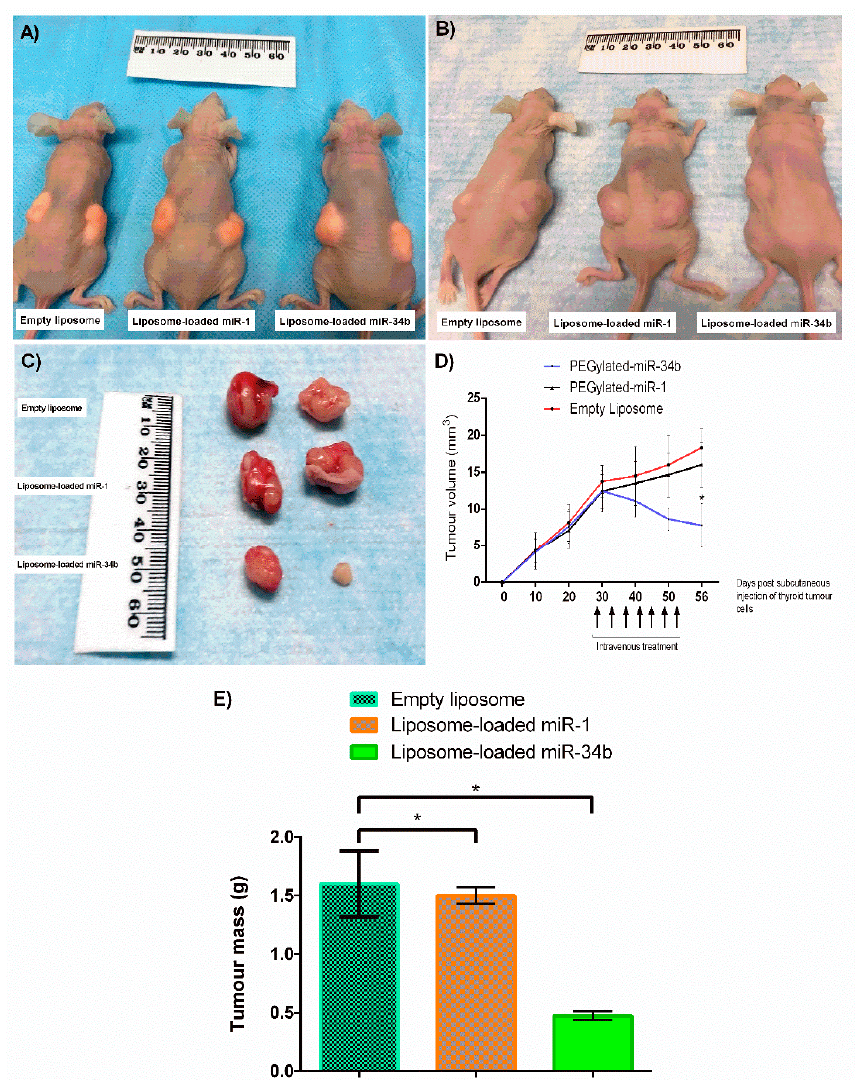
Figure 5. Inhibition of subcutaneous thyroid tumour growth in xenograft nude mouse by liposome-loaded miR-34b. The subcutaneous injection of anaplastic thyroid carcinoma cells (BHT-101) in mice, formed tumour after 28 days ( A ). All treatments were administrated on days 29, 33, 37, 41, 45, 49 and 53, after tumour cell inoculation and 40 µ g miRNA was used per dose. Mice that were intravenously injected with liposome-loaded miR-1 and empty liposome, generated larger tumour size, whereas smaller tumour observed in mice that received liposome-loaded miR-34b ( B ). Mice treated with liposome-loaded miR-34b had significant reduced tumour volume (mm 3 ) when compared to mice treated with liposome-loaded miR-1 and empty liposome ( n = 6) ( C and D ). Tumours were measured by calliper on subsequent days post initial subcutaneous (s.c.) injection of tumour cells. Results are shown as mean ± SD. Level of significance, * p < 0.05, when compared to the control groups. At the beginning of the in vivo study, the weight of mice in liposome-loaded miR-34b, liposome-loaded miR-1 and empty liposome treated group were 20.8 ± 0.04, 21.9 ± 0.1, 22.0 ± 0.09 gram respectively. After 56 days of observation, the weight of mice in liposome-loaded miR-34b treated group was 23 ± 2.0 gram whereas in liposome-loaded miR-1 and empty liposome treated group were 24.8 ± 0.6 and 23.8 ± 0.4 gram, respectively. There was no statistical difference in mouse body weight between the treated and non-treated group. The weight of tumours measured and were significantly lower in liposome-loaded miR-34b compared to liposome-loaded miR-1 and empty liposome treated group ( E ). This indicates that there is no toxicity in treated and non-treated